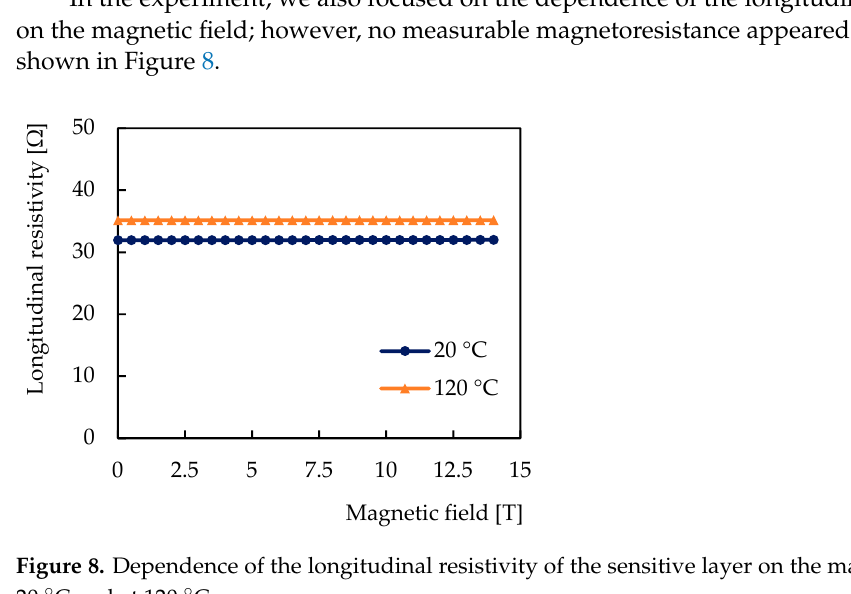
Figure 8. Dependence of the longitudinal resistivity of the sensitive layer on the magnetic field at 20 °C and at 120 °C.